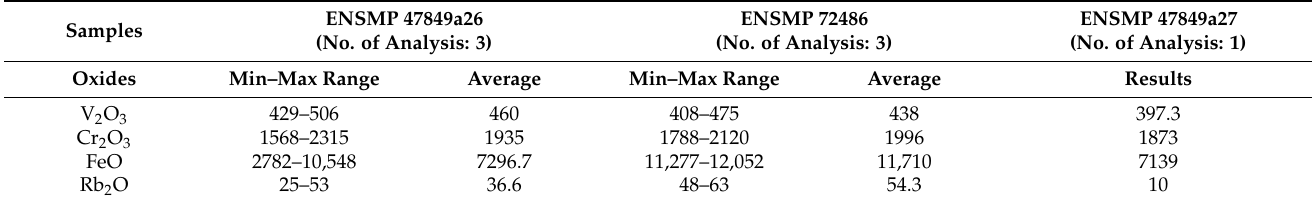
Table 4. Results of EDXRF analysis of Egyptian emerald crystals samples in host rock in ppm.